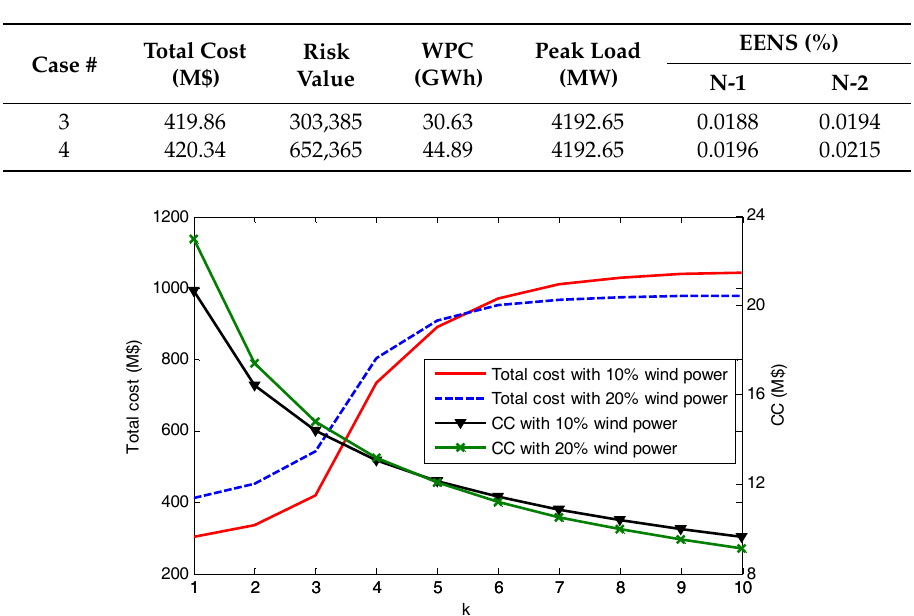
Table 6. Results comparison for cases 3 and 4 with 20% wind power.